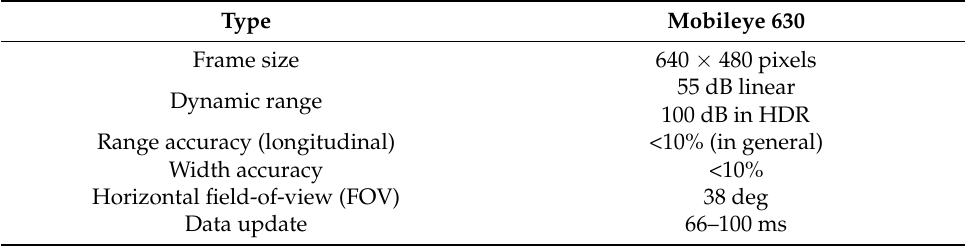
Table 2. Automotive camera system